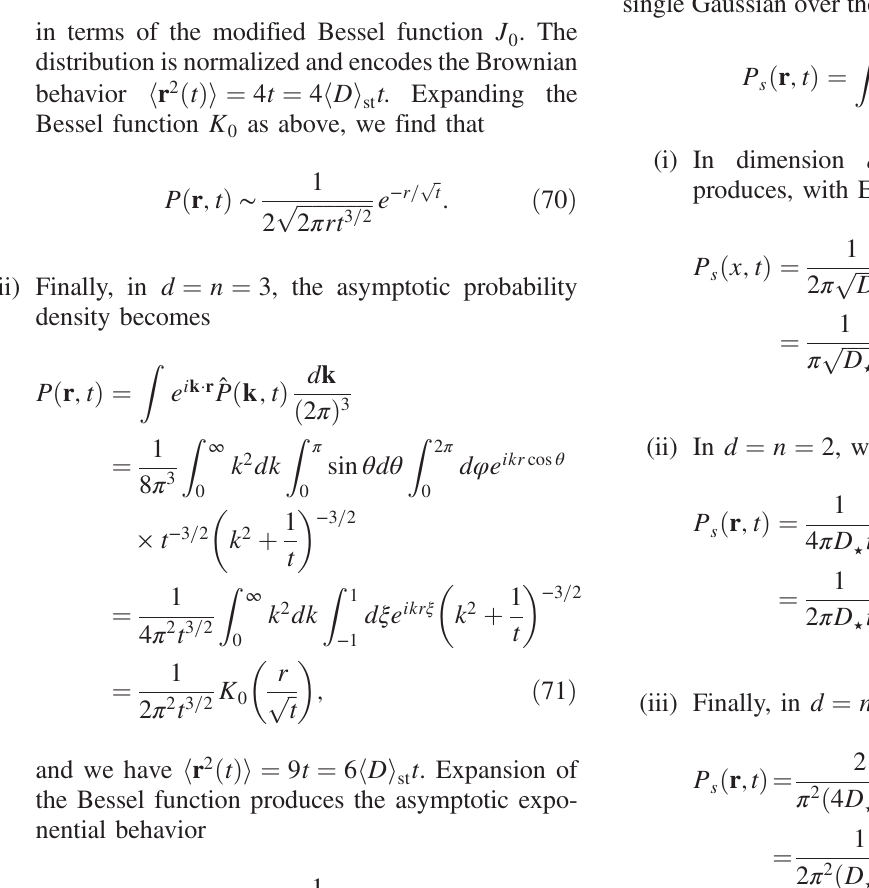
FIG. 4. Probability density function P ð x; t Þ for d ¼ n ¼ 1 at short times in dimensionless form ( σ ¼ τ ¼ D ⋆ ¼ 1 ). We com- pare results from simulations of the set of Langevin equa- tions (20a) – (20c), represented by the symbols, with the explicit short-time solution (63). Excellent agreement is ob- served; only for the longest time t ¼ 0 . 5 do the wings start to show some